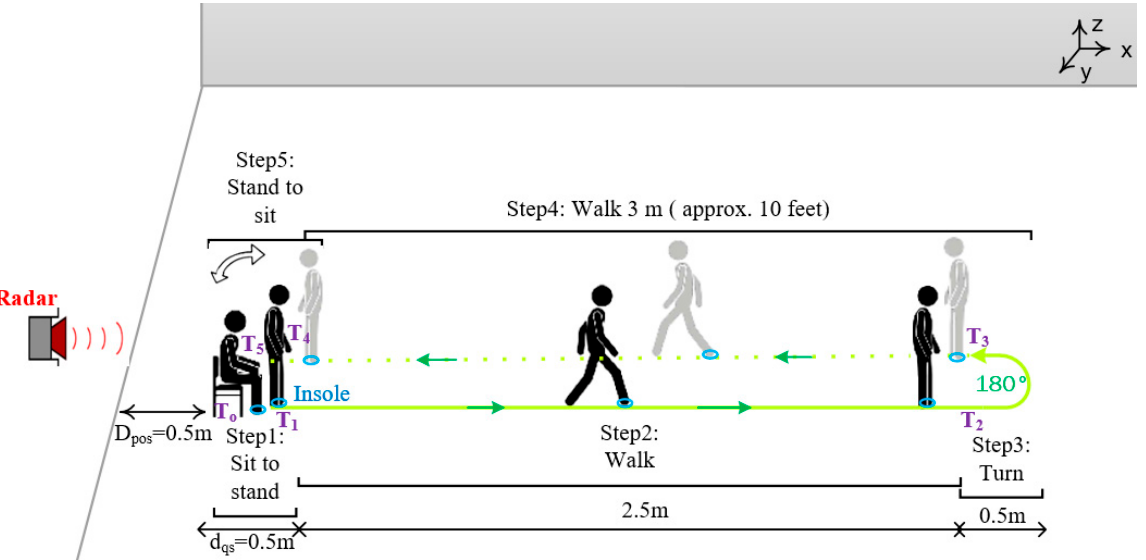
Figure 2. Experimental setup for home daily risk of falling evaluation using UWB radar and instrumented insole. (D pos : the distance between the location of the radar and that of the chair; d qs : the distance between the chair and the person in standing position, which correspond to the sit-to-stand activity).